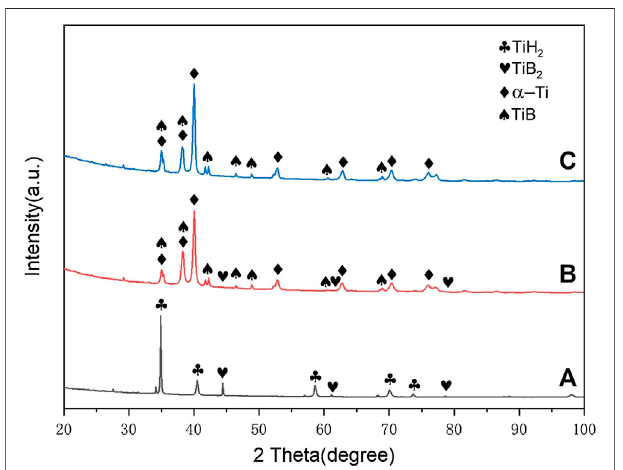
FIGURE 4 | Dilatometric heating curves for (1) compacted TiH 2 powder; (2) TiH 2 + 5% TiB 2 powder blend; (3,4) TiH 2 + 10% TiB 2 powder blends; and (5) hydrogenated, pre-alloyed Ti/TiB powdercompacts.The TiB 2 particlesare (2, 3) < 25 µm and (4) < 8 µm in